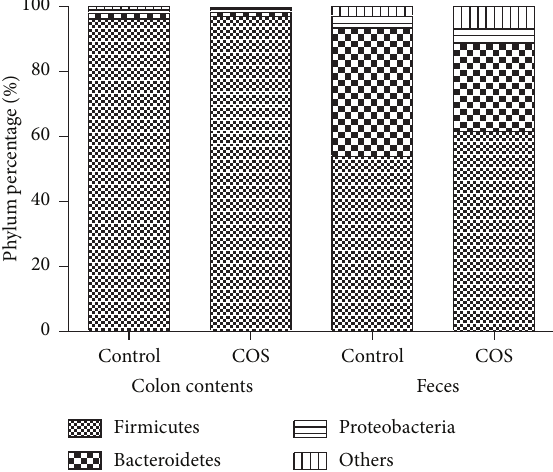
Figure3:D7postinfectioncompositionoftheintestinalmicrobiota. Microbial composition in the colon and feces of both groups ( 𝑛 = 6 ). Control mice were given standard drinking water and a basal rodent diet, whilst COS mice were given the same water and diet with the addition of COS at